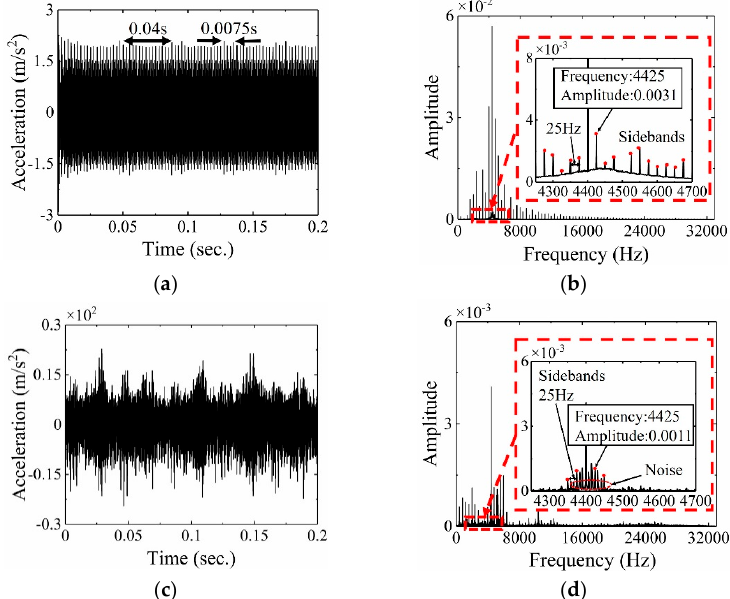
Figure 15. The simulated and experimental signal in the meshing line direction (two teeth with spalling fault, which are separated by one healthy tooth): ( a ) simulated signal, ( b ) simulated frequency signal, ( c ) experimental signal, and ( d ) experimental frequency signal.